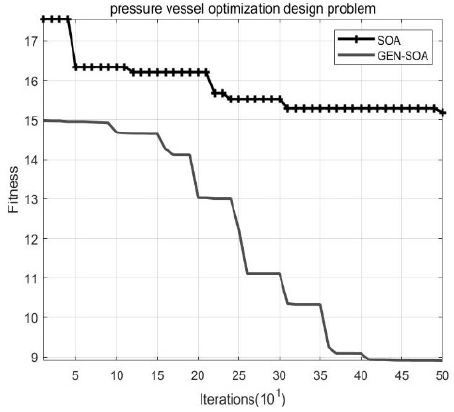
Figure 5. The pressure vessel.